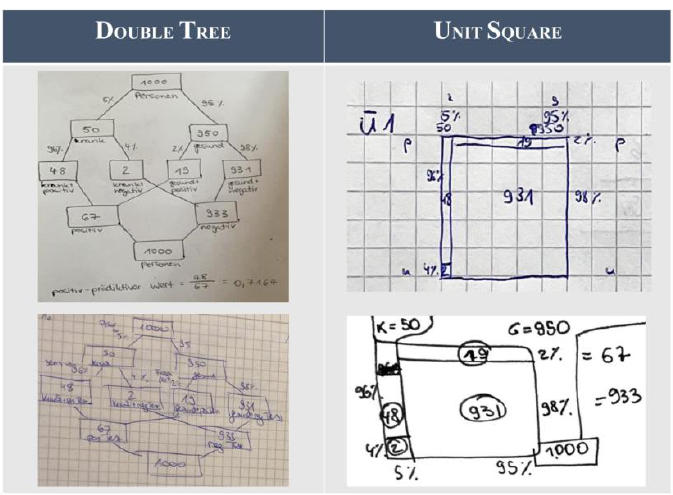
Figure 11. Notes of the students while working on the learning task on the aspect of performance (after having gone through the supportive information).